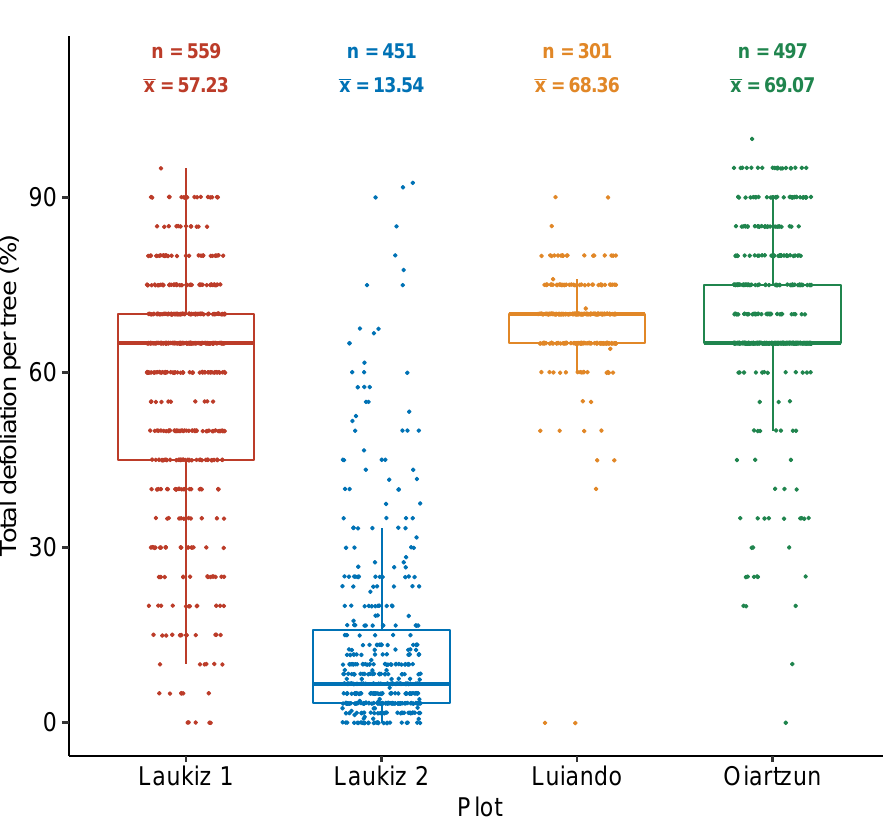
Figure 1. Response variable “defoliation of trees” for plots Laukiz1, Laukiz2, Luiando, and Oiartzun. n is the total number of trees in each plot, and ¯ x the mean defoliation. Values for Laukiz1, Luiando, and Oiartzun were observed in 5% intervals; for Laukiz2, defoliation was observed at multiple heights and then averaged, leading to smaller defoliation differences than